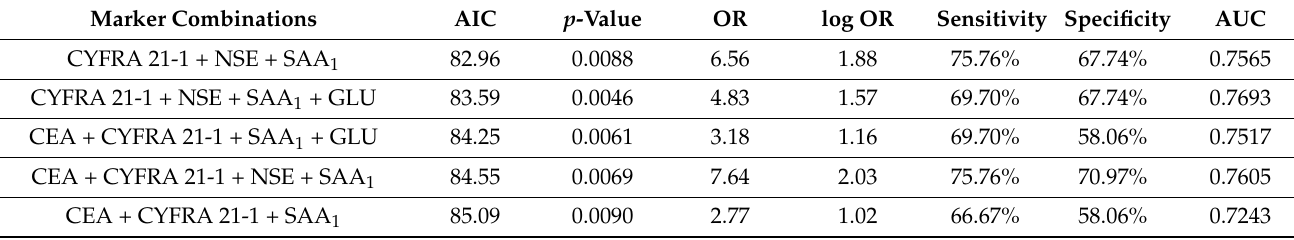
Table 10. The diagnostic efficiency of multi-biomarker models to distinguish NSCLC patients with adenocarcinoma from patients with squamous cell carcinoma.